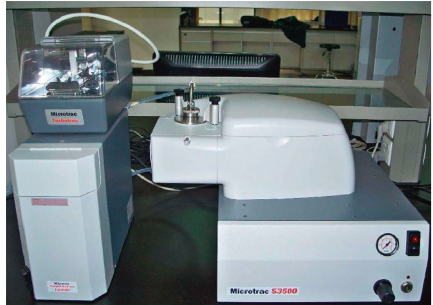
Figure 2: MICROTRAC S3500 laser particle size